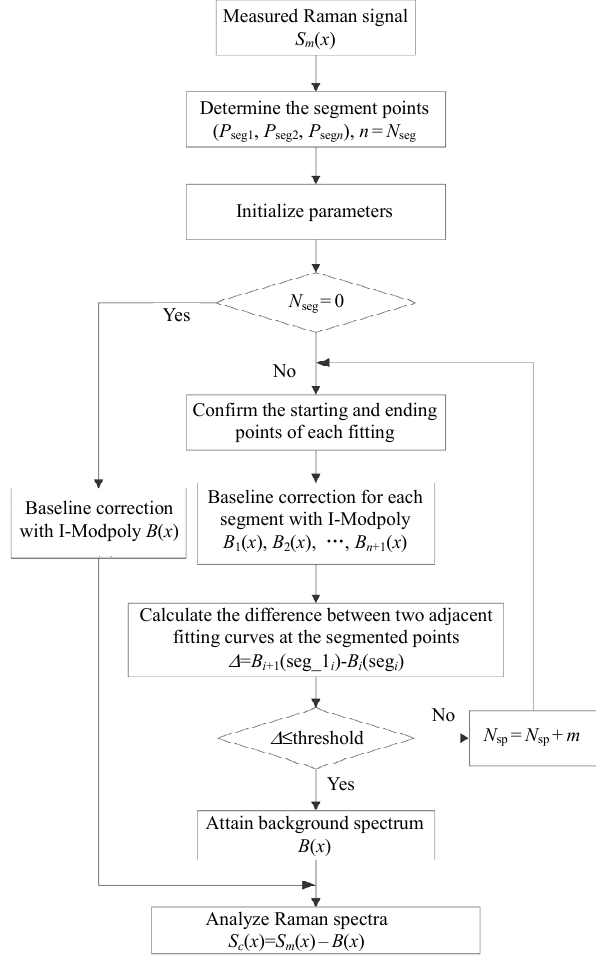
Fig. 2 A detailed diagram of the PPF